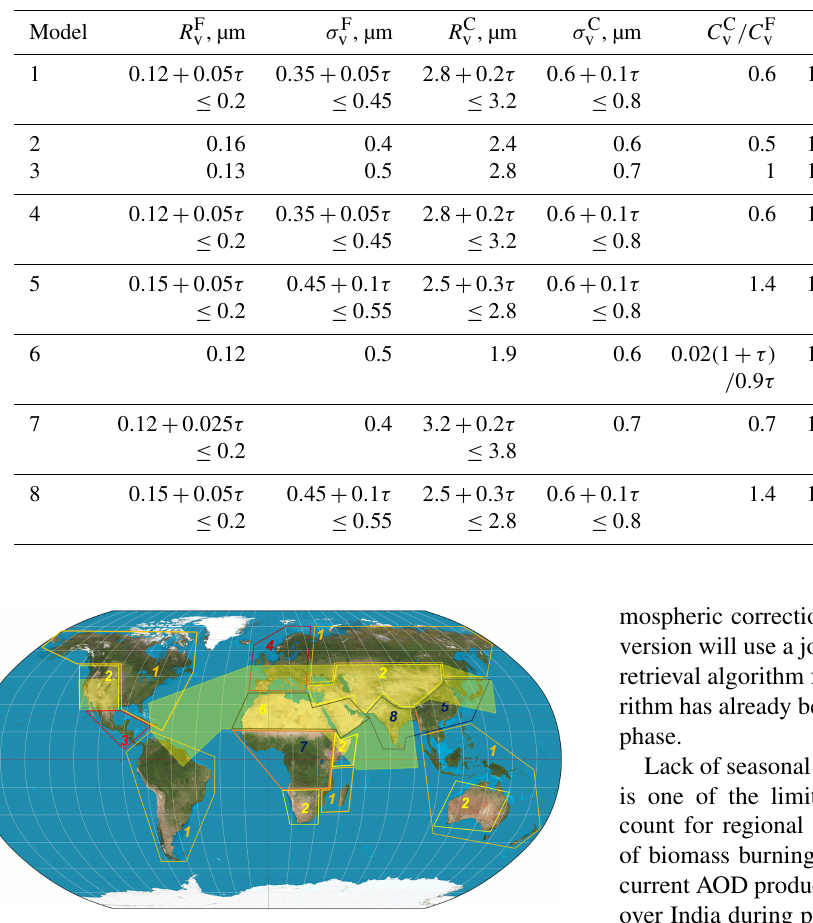
Table 1. Microphysical properties of MAIAC aerosol models: radius and standard deviation of fine and coarse fractions of bi-lognormal volume size distribution; ratio of volume concentrations (coarse to fine) as functions of AOD ( τ ); real and imaginary refractive index ( n = m- ik); Ångström (AAE) parameter for k ( k(λ) = k(λ 0 )(λ/λ 0 ) − b , for λ < λ 0 = 0 . 66µm and k(λ) = k(λ 0 ) for λ > λ 0 ) . Finally, the last column shows the fraction of spherical particles where 1 represents spheres and 0 represent spheroids from the DLS model (Dubovik et al., 2006).